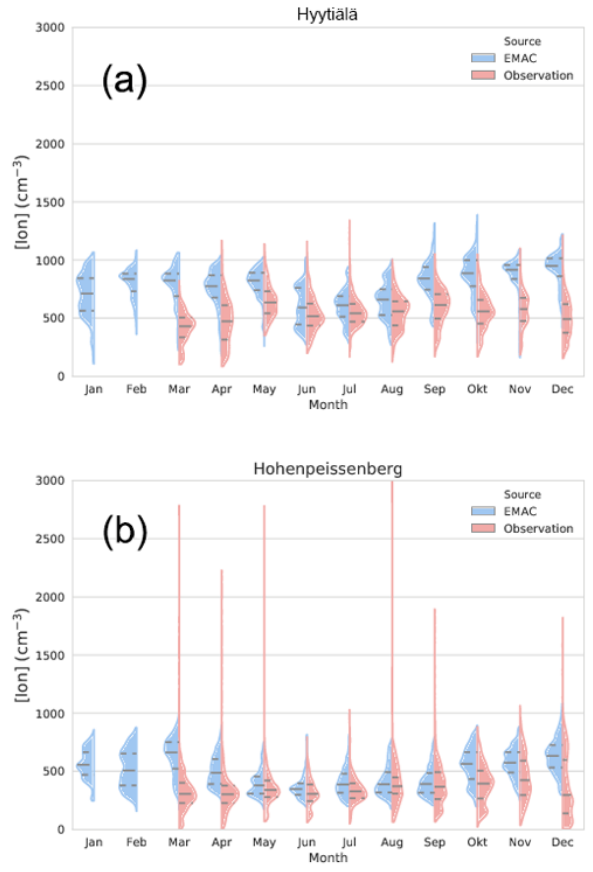
Figure 2. Monthly distribution of observed and simulated ion con- centrations at two locations in 2008. The station codes are above each panel. Blue areas (left half of each area) modelled distribu- tion; red (right) areas modelled observed values. For January and February 2008, no station had ion data available.